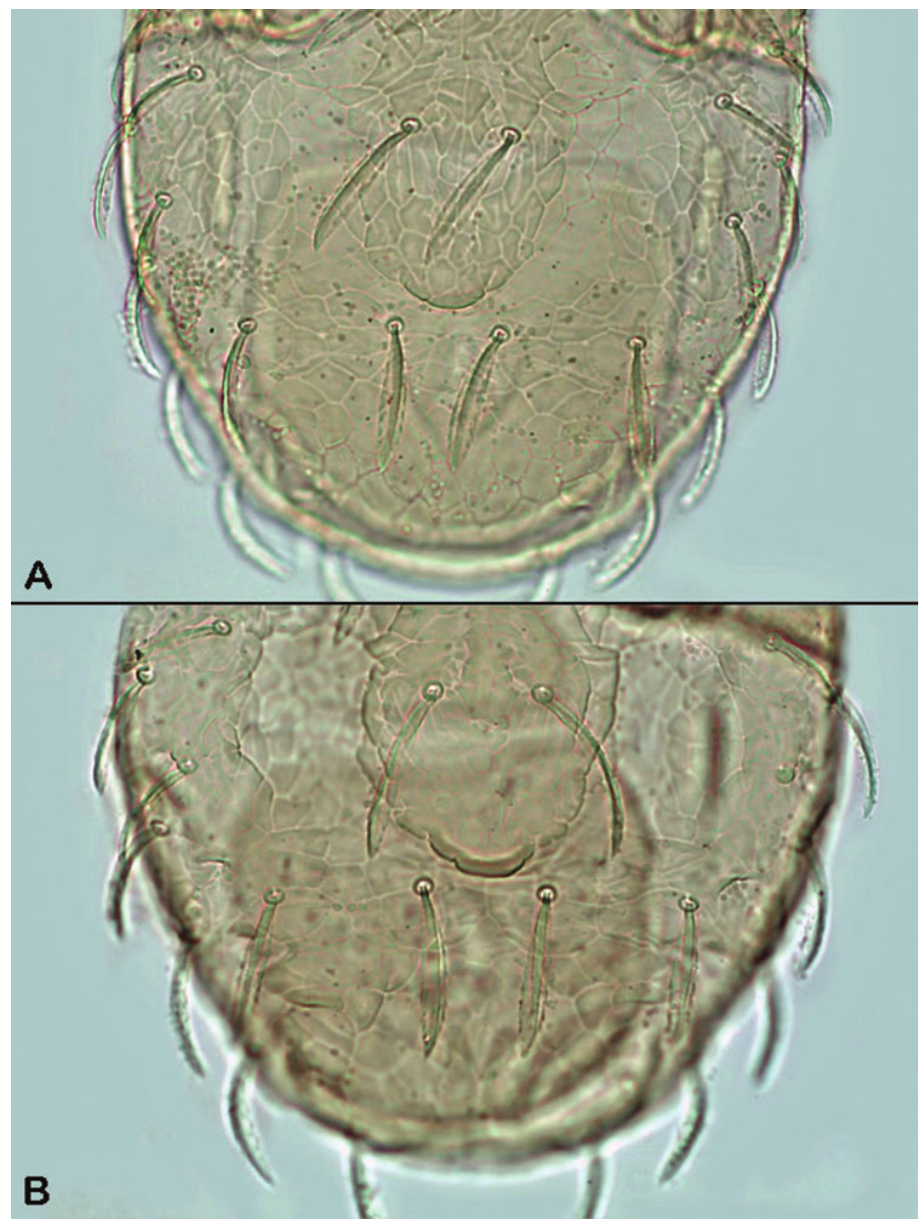
Plate 56. Kleemannia plumosa , female, posterior part of dorsal shield. A A form with shorter dorsal setae B A form with longer dorsal